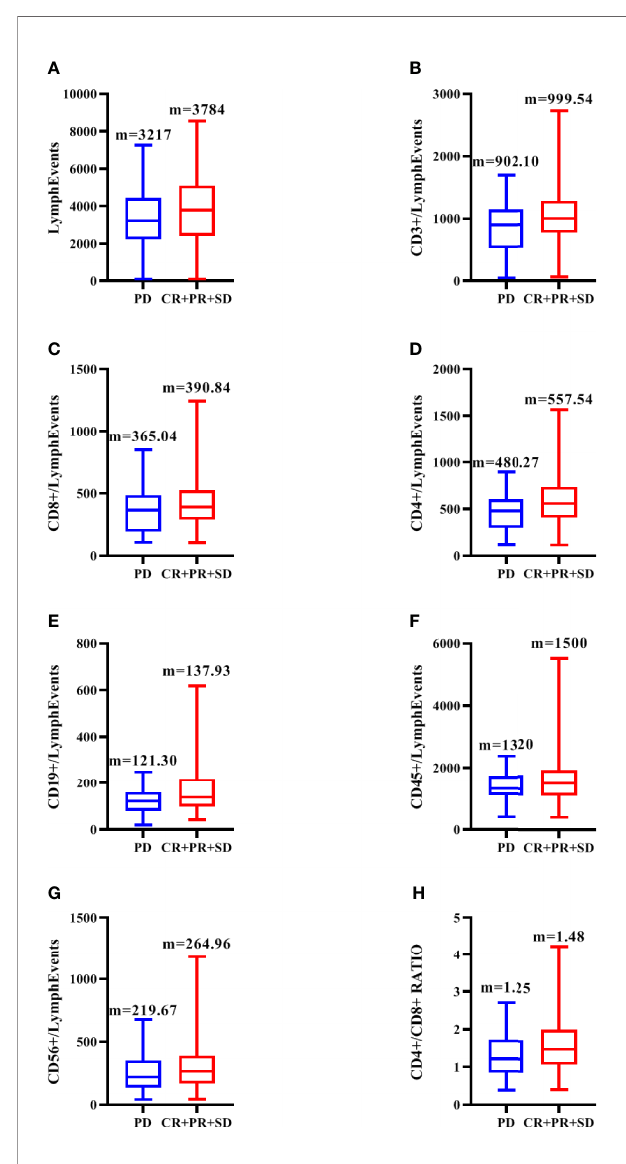
FIGURE 2 | Distribution of peripheral blood total lymph events (A) , CD3+ (B) , CD8+ (C) , CD4+ (D) , CD19+ (E) , CD45+ (F) , CD56+ (G) and CD4+/CD8+ (H) in CR/PR/SD subgroup and PD subgroup. M is the median of each lymphocyte